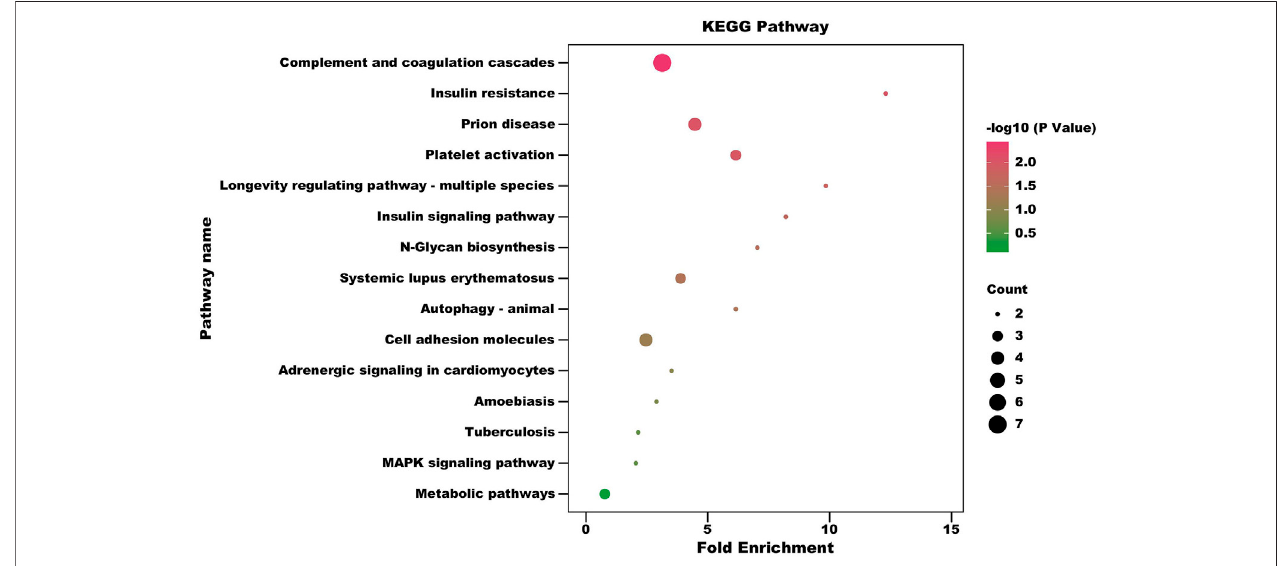
FIGURE 4 | Pathway enrichment bubble diagram of differential expressed proteins of CSF (Fold change = 1.5). The horizontal axis represents fold enrichment: multiplesofthetotalproportionofdifferentiallyexpressedproteinsintheKEGGsignalingpathwayrelativetotheproportionofidenti fi edproteinsinthissignalingpathway; The ordinate represents KEGG term description; Bubble size indicates the number of differential proteins in the KEGG signaling pathway. Fisher exact test p value: p values of the enrichment test obtained using Fisher ’ s exact test.